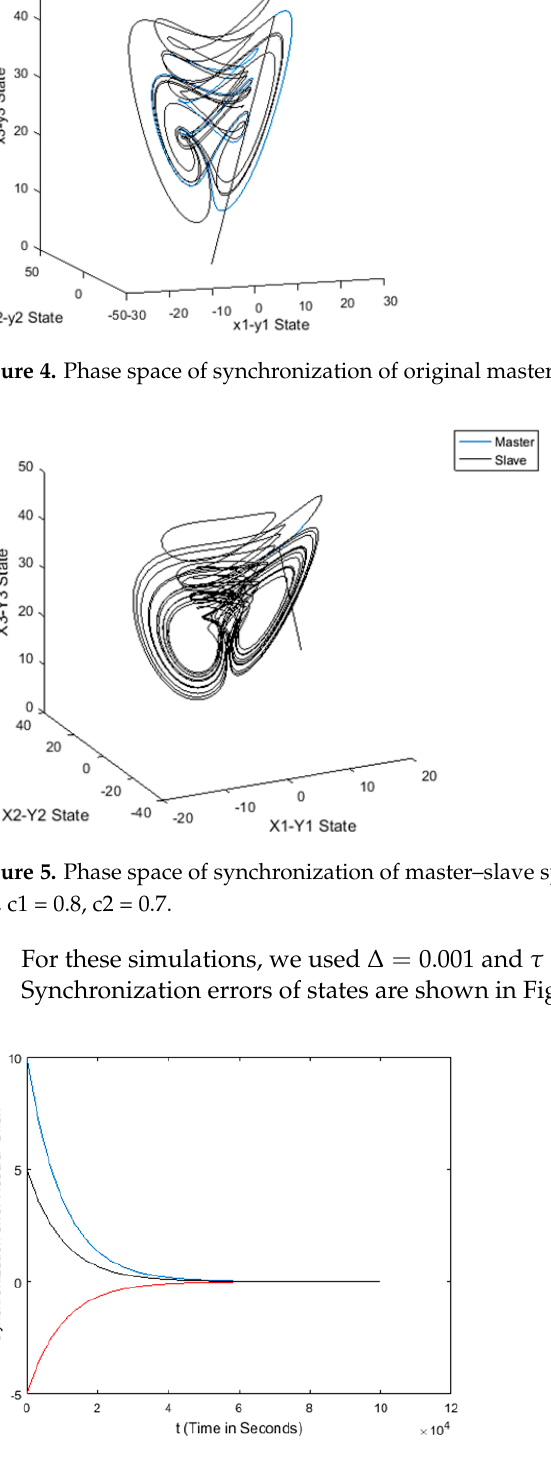
Figure 6. Synchronization errors with time delay between states of master and slave system of variable fractional order derivative.